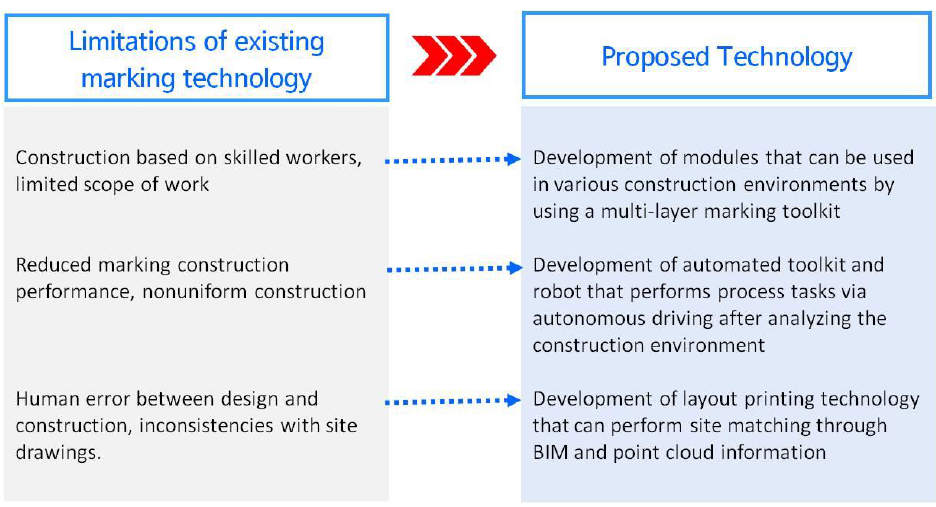
Figure 3. Scope of layout-printing technology that considers process